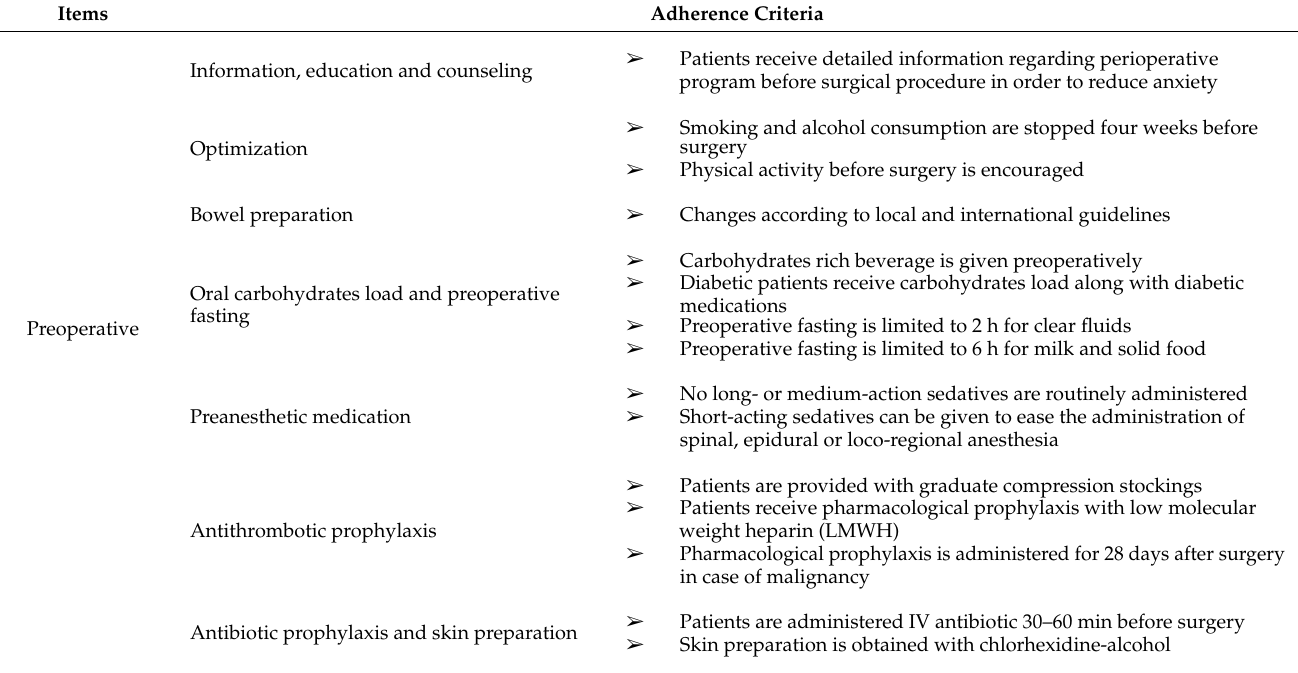
Table 1. Enhance Recovery After Surgery items and adherence criteria following 2013 guidelines [15]. Items Adherence